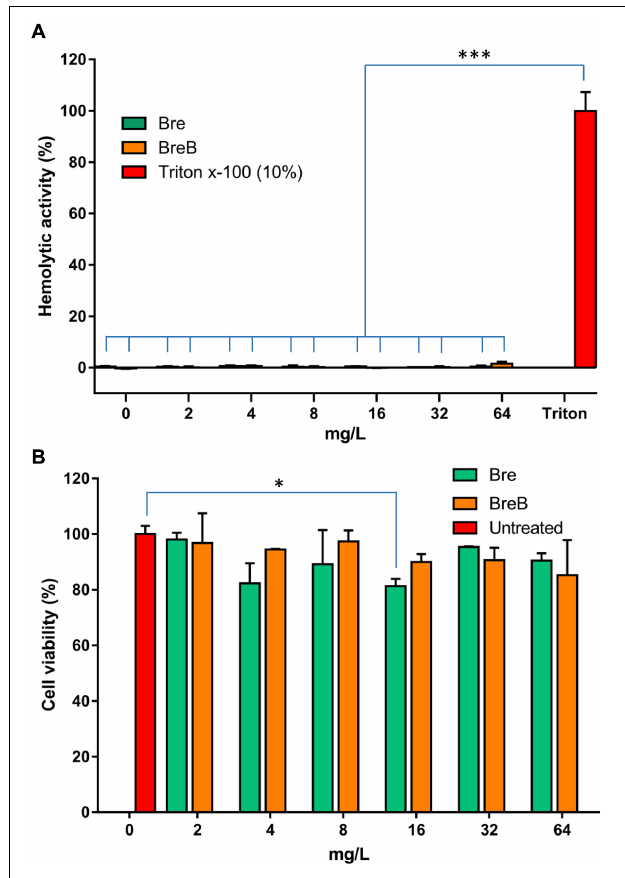
FIGURE 5 | Brevicidines show exceptional low cytotoxicity and hemolytic activity. (A) Human erythrocytes were incubated with brevicidines at concentrations ranging from 2 to 64 mg/L. Their hemolytic activity was assessed by the release of hemoglobin. Cells treated without a tested compound were used as no-lysis control. Cells treated with 10% Triton X-100 were used as complete lysis control. The data are representative of three independent experiments. Correlation analyses were evaluated by Pearson r2, ns: p > 0.05, * p < 0.05, and *** p < 0.001 vs. 10% Triton X-100-treated cells. (B) Cytotoxicity of brevibacillins against HepG2 cells. The data are representative of three independent experiments. Correlation analyses were evaluated by Pearson r2, ns: p > 0.05, * p < 0.05, and *** p < 0.001 vs. Untreated